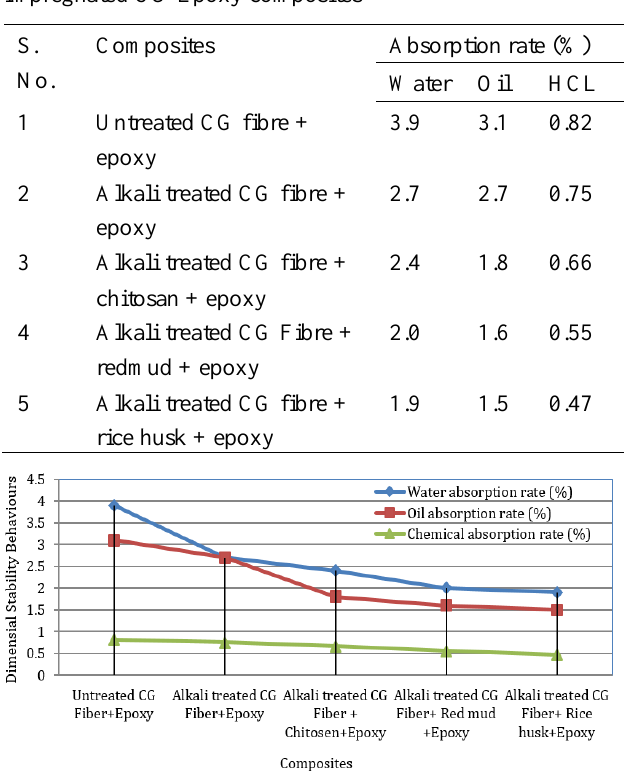
Fig. 6. Izod impact failure of particulates impregnated CG- Epoxy composites Table 2 Dimensional stability characteristics of particulates impregnated CG-Epoxy composites